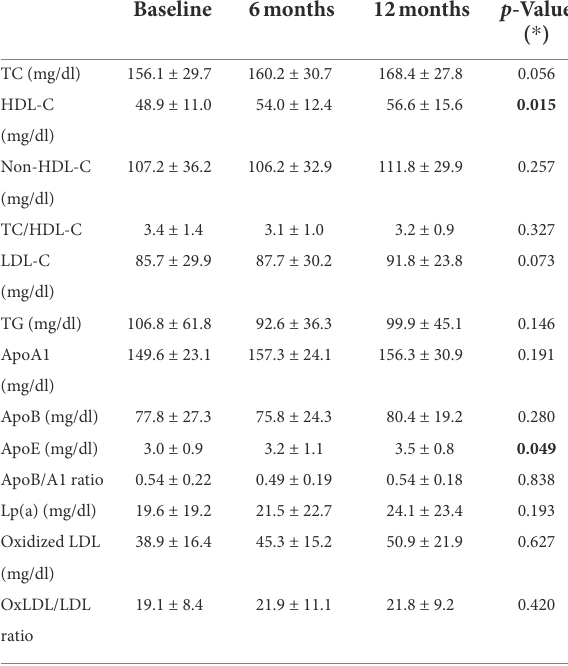
TABLE 2 Patient’s lipid